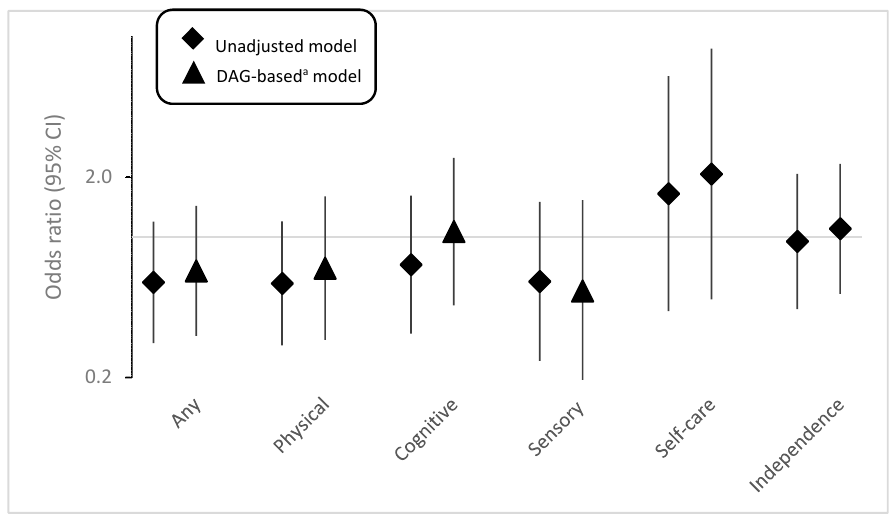
Figure 2. Associations between disability and infertility-related doctor visit among those reported infertility . a DAG-based model adjusted for age, race, and education. The Y -axis is displayed on the logarithmic scale.